Question: Sum up the contents of this chart in one sentence.
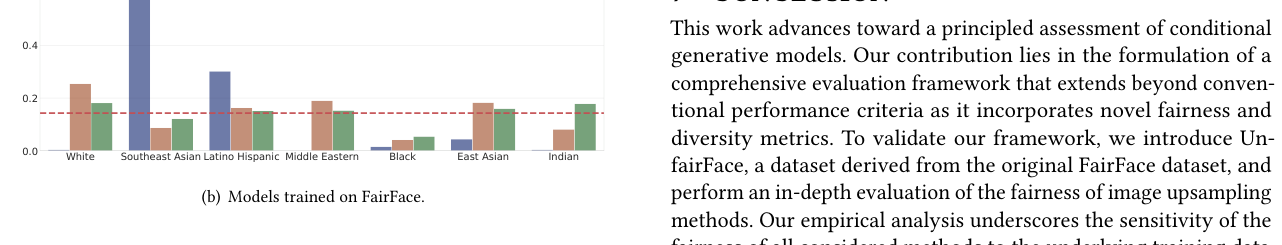
Answer: Comparing the uninformative conditional propor- tional representation distribution PUCPR of models trained on UnfairFace and FairFace. The horizontal dashed line indi- cates the bar height corresponding to a uniform distribution.